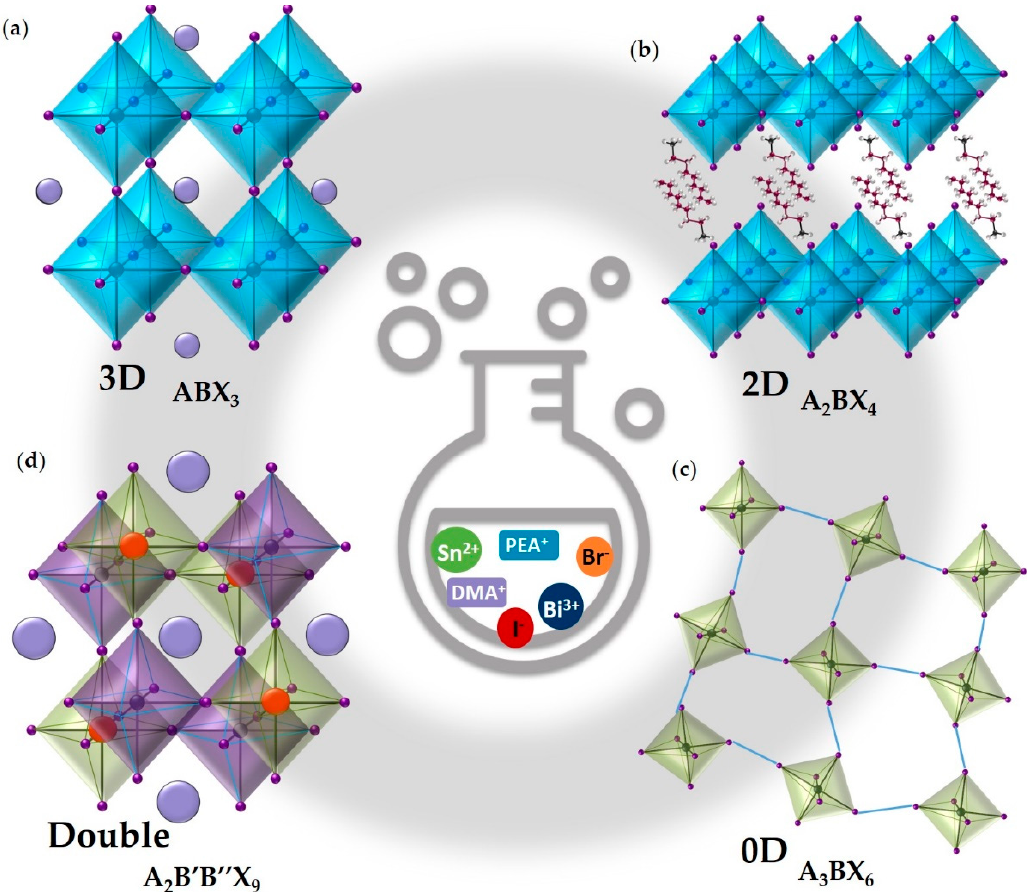
Figure 2. Examples of schematic crystal structures with the related chemical formula of ( a ) 3D, ( b ) 2D, ( c ) 0D and ( d ) double MHPs used for H 2 evolution from aqueous solutions.